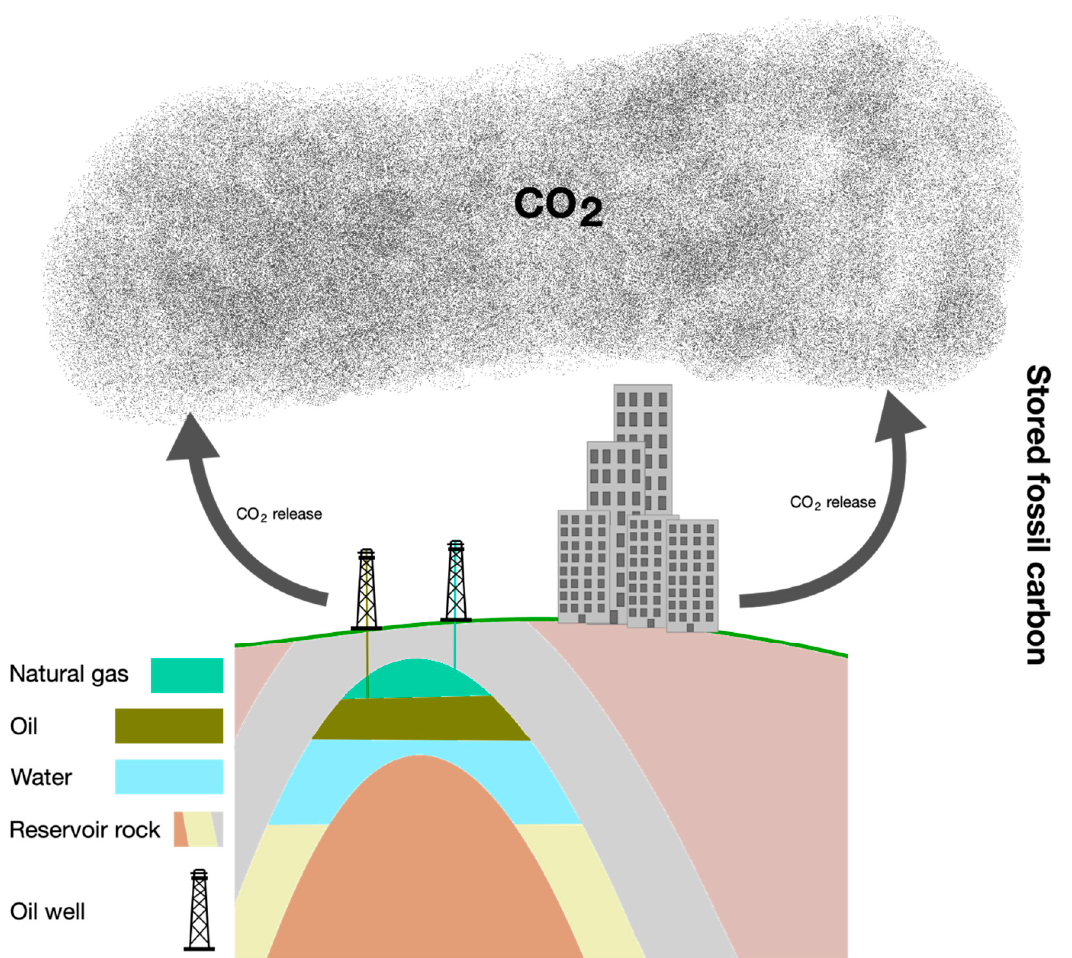
Figure 1. The release of carbon sequestered and stored in the distant past is most likely the leading cause of accelerating climate change. The increasing use of fossil fuels since the period of the industrial revolution is, on the one hand, the basis of societal development as it has made available accessible energy sources, but, on the other hand, it has contributed greatly to pollution and to the increased concentration of CO 2 in the atmosphere.